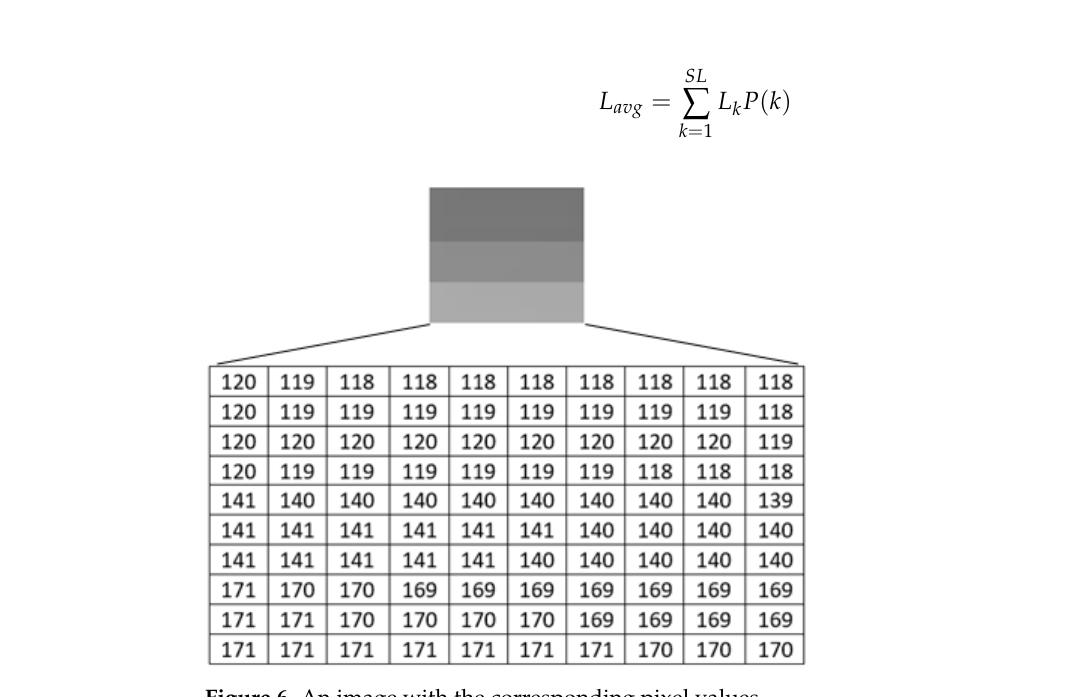
Figure 6. An image with the corresponding pixel values. Table 1. Variable length coding for the image in Figure